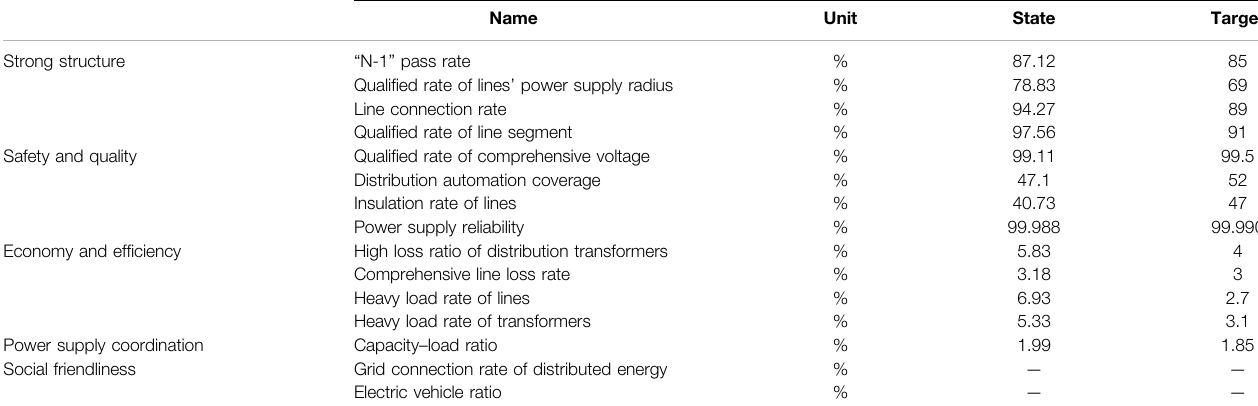
TABLE 2 | Power system diagnosis results. Target layer